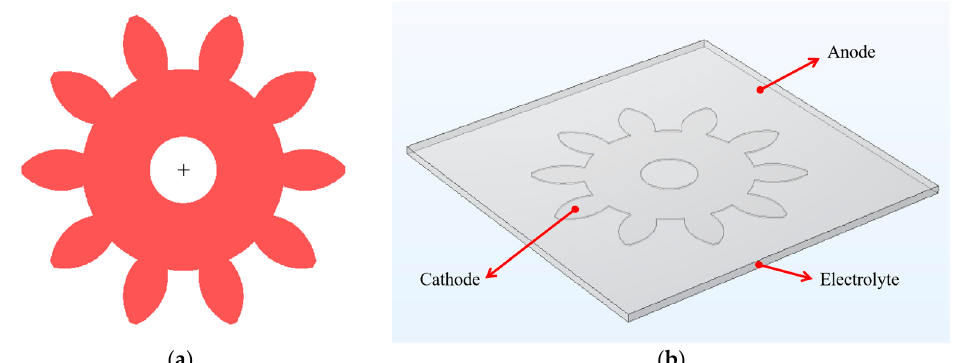
Figure 1. ( a ) Plane structure diagram of the micro gear; ( b ) geometric model.